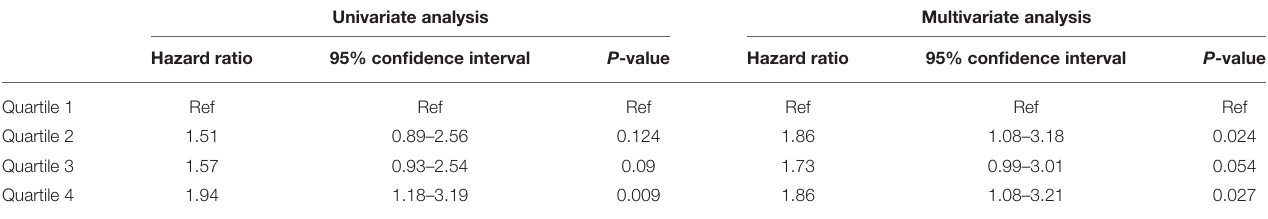
TABLE 2 | Association between TWA quartiles of Mg level and the primary composite outcome of MACE and overall death by univariate and multivariate analysis.